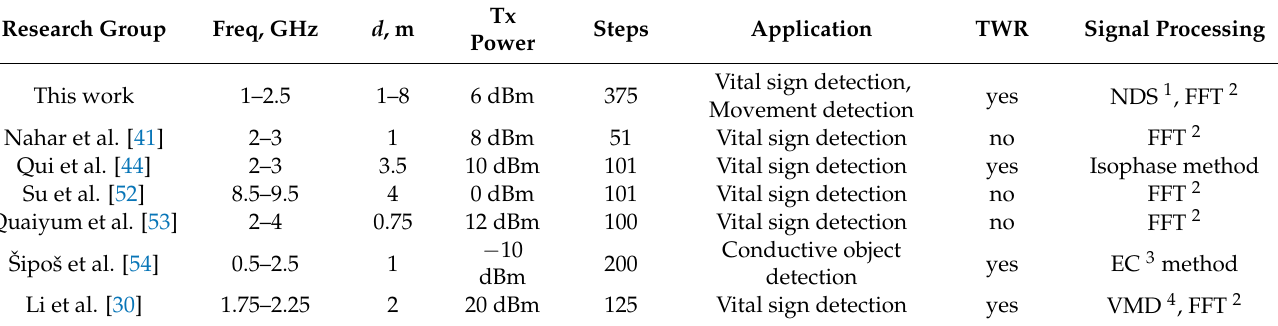
Table 1. The comparison chart of radar systems exploiting SCFW